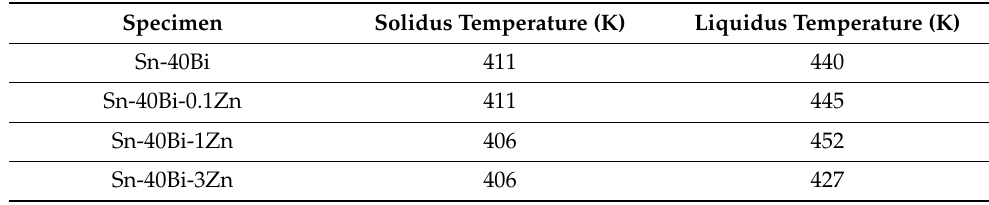
Table 2. Solidus and liquidus temperatures of the Sn-40Bi-Zn alloys.